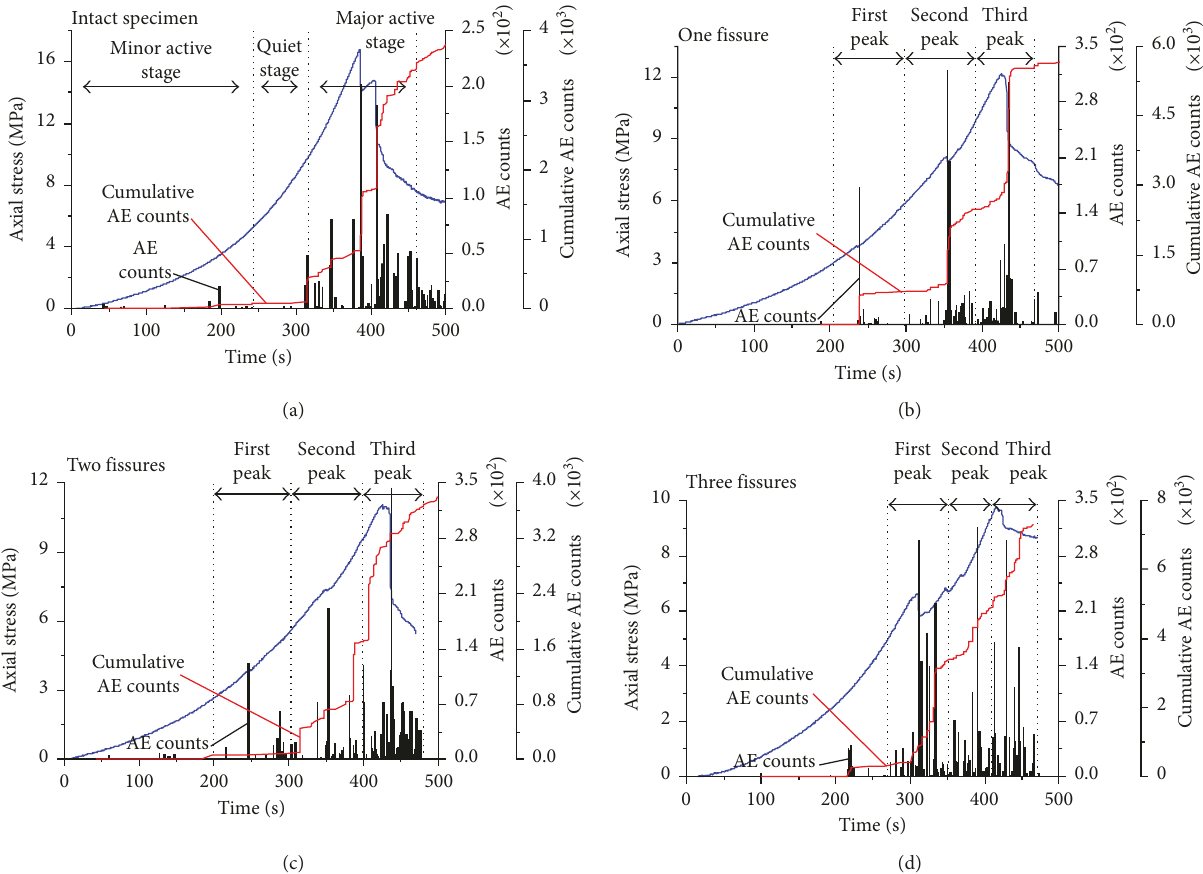
Figure 8: AE characteristics of specimens during the uniaxial loading process: (a) intact specimen, (b) one fissure specimen, (c) two fissure specimens, and (d) three fissure